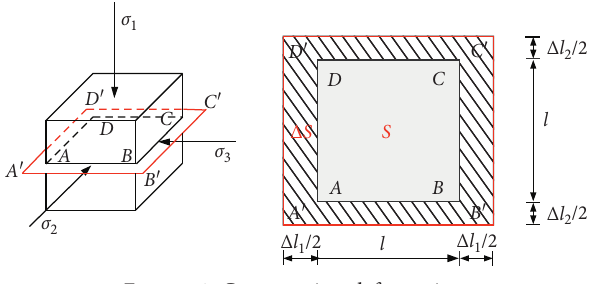
Figure 4: Cross-section